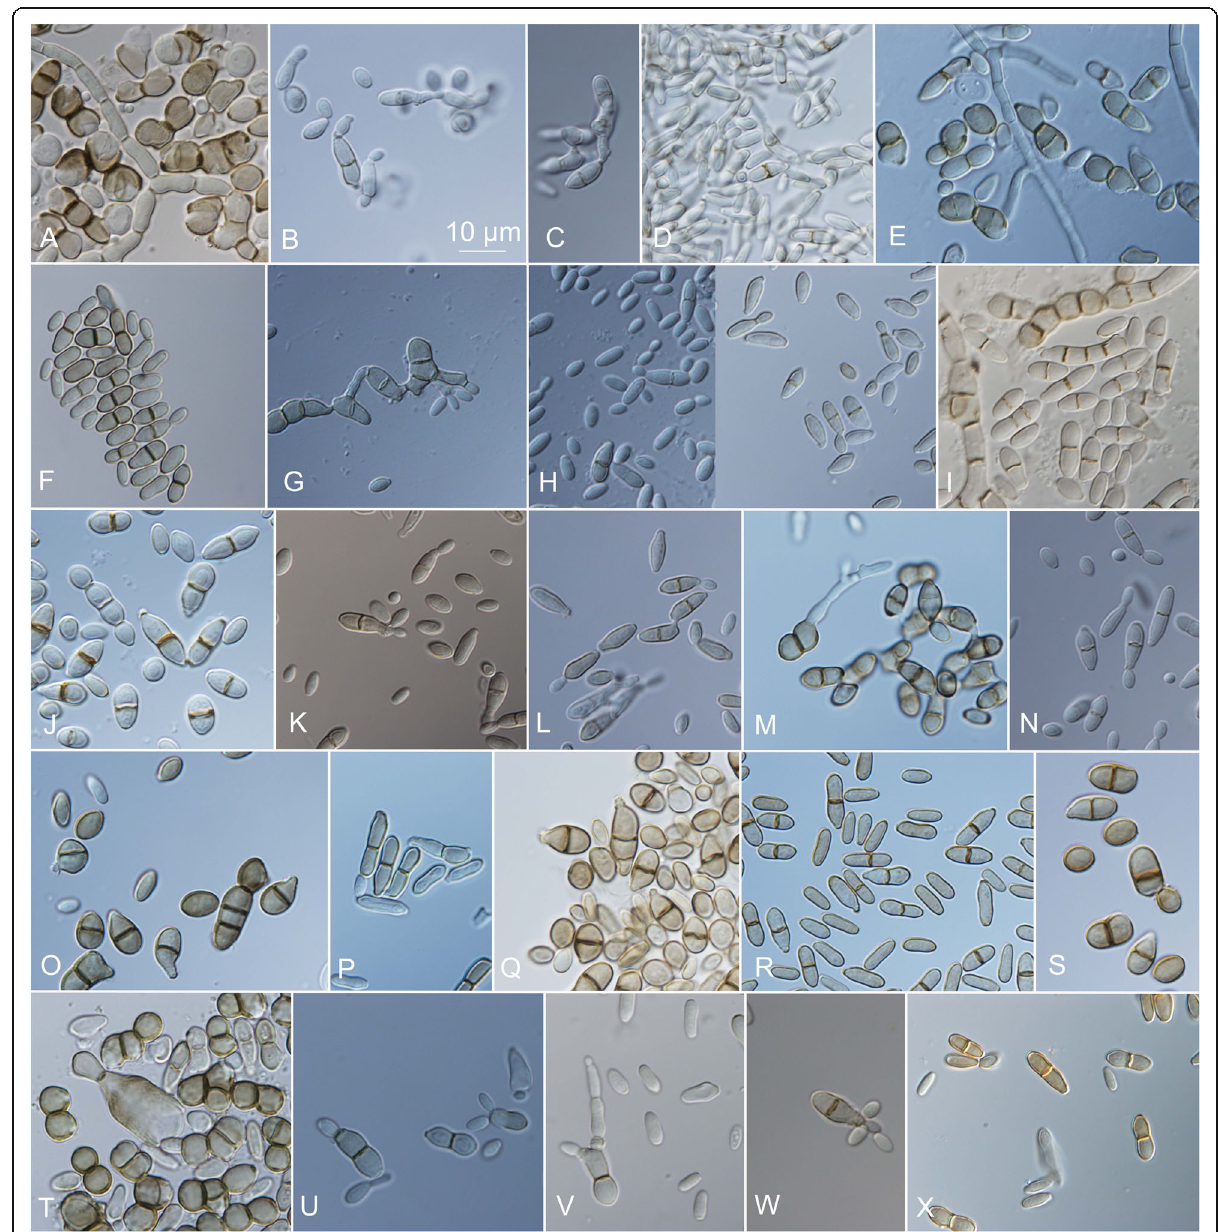
Fig. 13 Conidia of Hortaea werneckii strains grown on oatmeal agar (OA) for 14 days at 25 °C. a EXF-120. b EXF-157. c EXF-161. d EXF-171. e EXF- 247. f EXF-562. g EXF-631. h EXF-2516. i EXF-2687. j EXF-2690. k EXF-2785. l EXF-2788. m EXF-3506. n EXF-4625. o EXF-6651. p EXF-6654. r EXF- 6656. s EXF-6669. t EXF-7620. u EXF-10508. v EXF-10512. w EXF-10513. x EXF-11537. Bar = 10 μ m (for